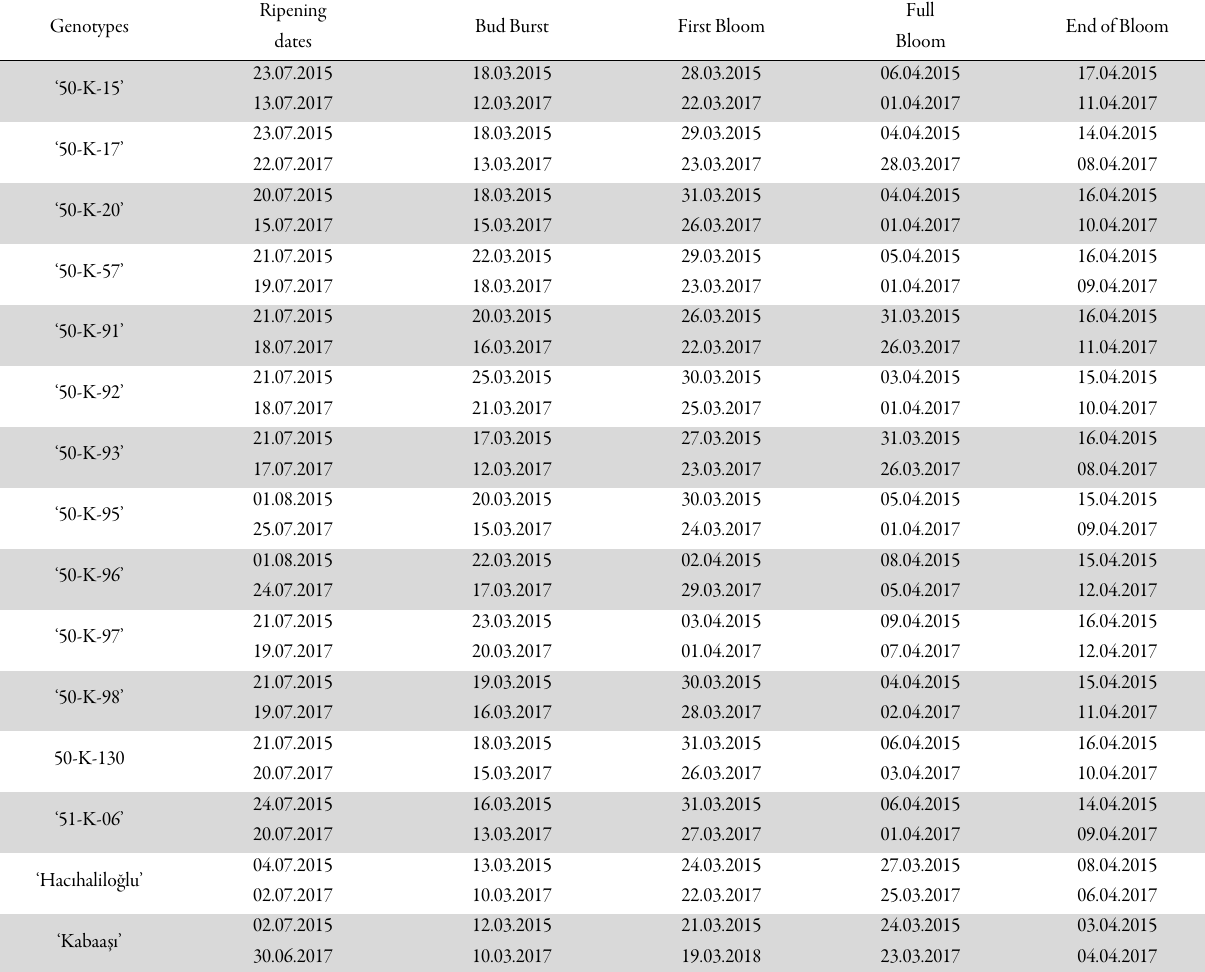
Table 1. Results of phenological observation in apricot genotypes (2015-2017)